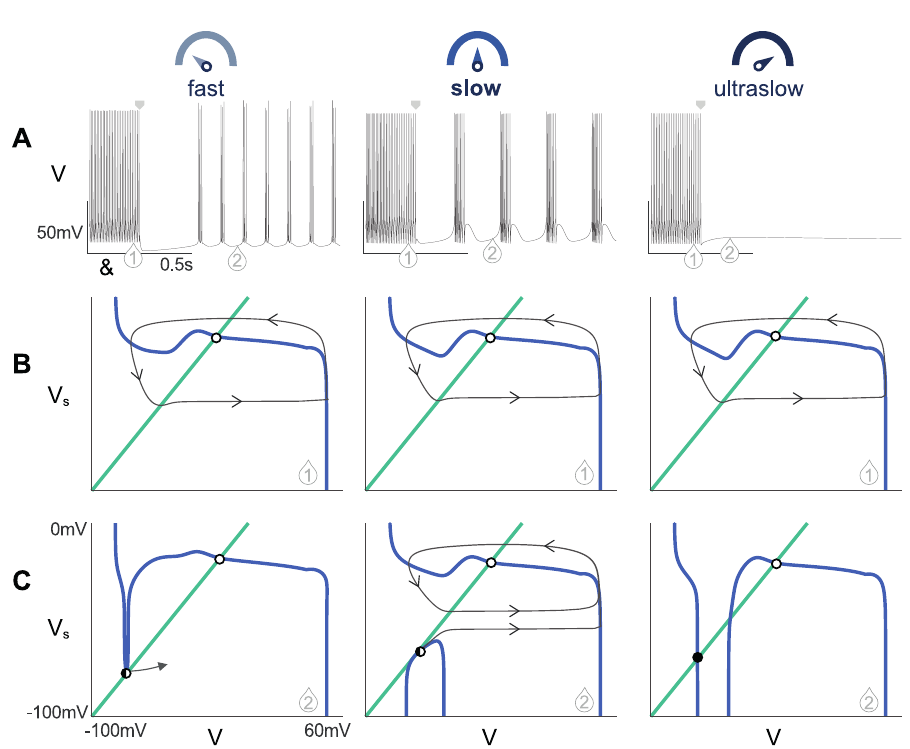
Fig 6. Distortion of the phase portrait when the T-type calcium channel activation is considered as fast, slow or ultraslow. A : Voltage traces of a reduced model under the three conditions during a hyperpolarized-induced bursting. The square arrow indicates the hyperpolarizing current step. When the CaT activation is ultraslow, the model is not able to switch from tonic to burst. B : Comparison of the portrait geometry during tonic mode (arrow 1) under the three timescales. V-(resp. Vs-) nullcline is sketched in blue (resp. green). The unstable fixed point is marked in open circle. The limit cycle followed by the trajectory is sketched in gray. The timescale chosen for the CaT channel activation is not affecting the tonic mode. C : Comparison of the portrait geometry during burst mode (at the saddle node bifurcation, arrow 2) under the three timescales. The stable fixed point is marked as a filled black circle and the saddle point meeting the stable fixed point is indicated by the black half-circle. At the ultraslow timescale (right), there is no saddle-node bifurcation,the V-nullcline is distorted into its hourglass shape trapping the trajectory into its stable fixed point. (left) For the fast CaT activation channel, the V-nullcline presents only the upper branch where the saddle node bifurcation occurs (center) For the slow activation, the V-nullcline exhibits a lower branch. This branch robustly separates the silent region and the spiking region of bursting. Videos of the simulations under the three conditions are available in S1 Video (fast), S2 Video (slow) and S3 Video